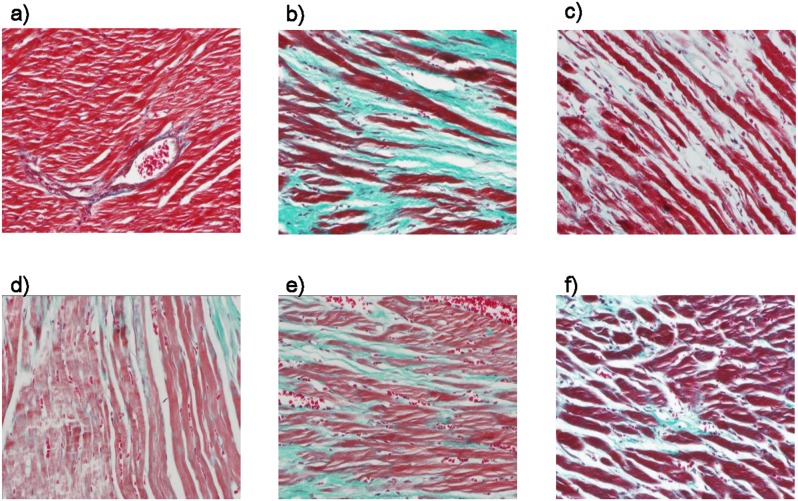
Effects of QSYQ on MASSON results after occlusion of the left anterior descending (LAD) artery in rats.Representative results of Masson trichrome staining of the left ventrentricle in sham group (a).; model group (b).; QSYQ (H) (c).; QSYQ (M) (d).; QSYQ (L) (e).; Captopril group (f). Blue staining indicates myocardial fibrosis. Masson trichrome staining revealed different degree fibrosis in different groups. In sham group, there were almost no fibrosis region. While in model group, there were significant fibrosis region. the increase was significantly attenuated in different dosage of QSYQ groups and Captopril group by contrast with those in the model group. n = 10∼14 for each group.